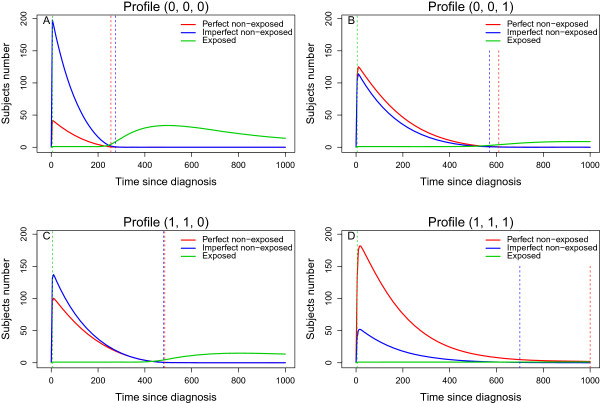
Number of subjects in the three possible groups. Number of subjects pertaining to the three possible subjects groups at each time t: the exposed subject (solid green line), the non-exposed subject who never will undergo the exposure (solid red line) and the non-exposed subject who will undergo the exposure (solid blue line). The dotted vertical green line represents the time of first exposure, i.e. the time of occurrence of the first pair; the dotted vertical blue line corresponds the time of the last perfect pair’s creation; and the dotted vertical red line corresponds the time of the last imperfect pair’s creation. Results obtained with the increasing then decreasing HR(t) configuration, without censoring and with β12′=(−0.2,−0.4,−0.8), β13=−β12 and β23=−β13.